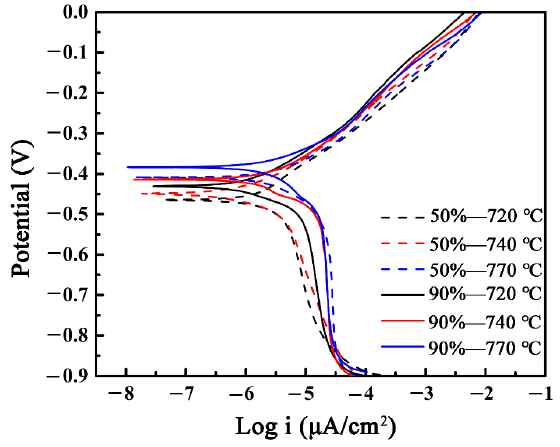
Figure 13. Potentiodynamic polarization curves of the experimental steels in 3.5 wt.% NaCl solution. Table 3. i corr , E corr values of specimens at 50% deformation with different annealing temperatures derived from the potentiodynamic curves.